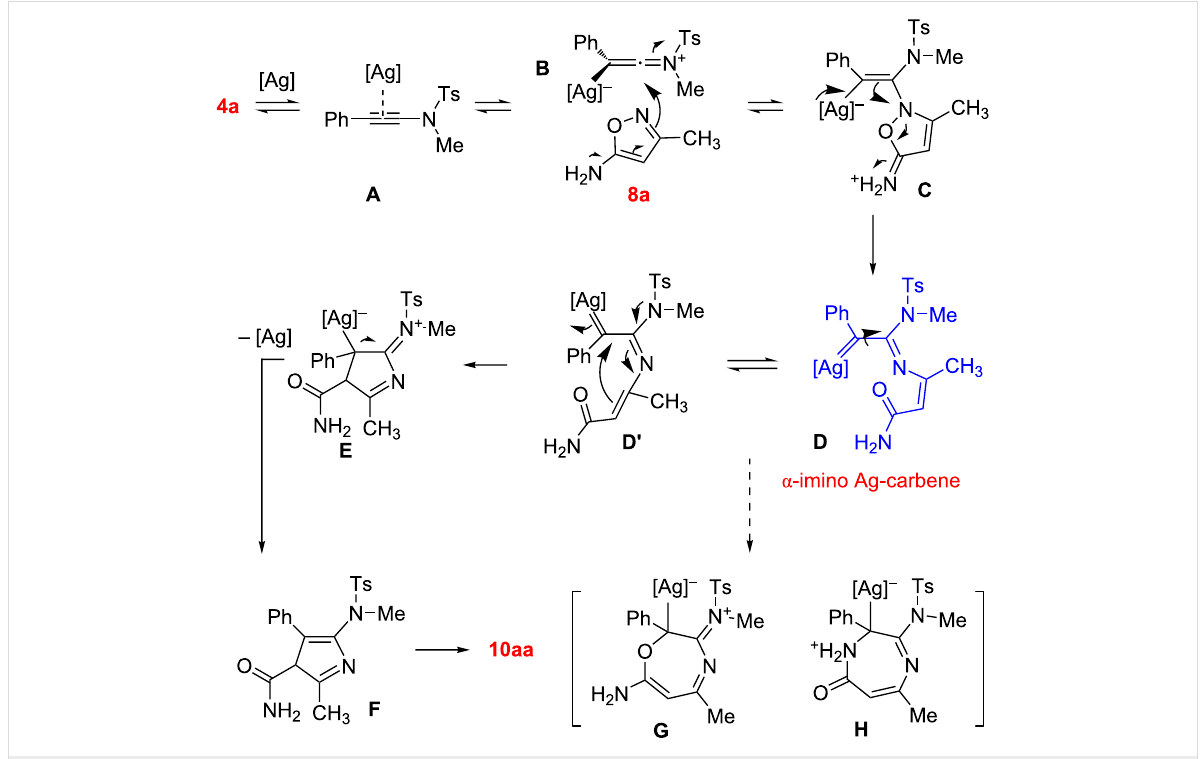
Scheme 5: Mechanistic hypotheses for Ag-catalyzed reaction of ynamide 4a with aminoisoxazole 8a .